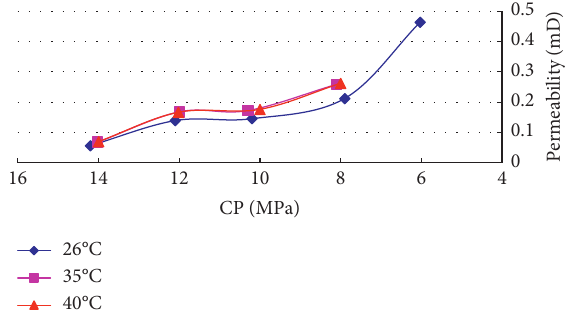
Figure 8: Variation in permeability during confining pressure unloading at a gas pressure of 4 MPa.